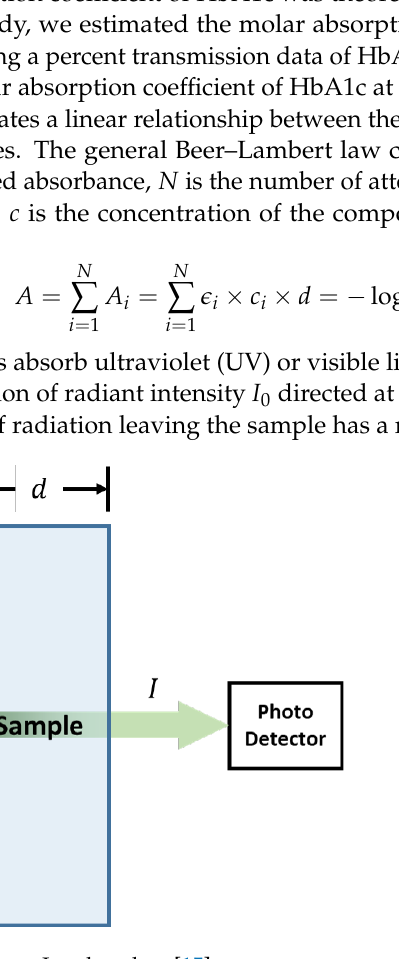
Figure 1. Illustration of Beer – Lambert law [15].